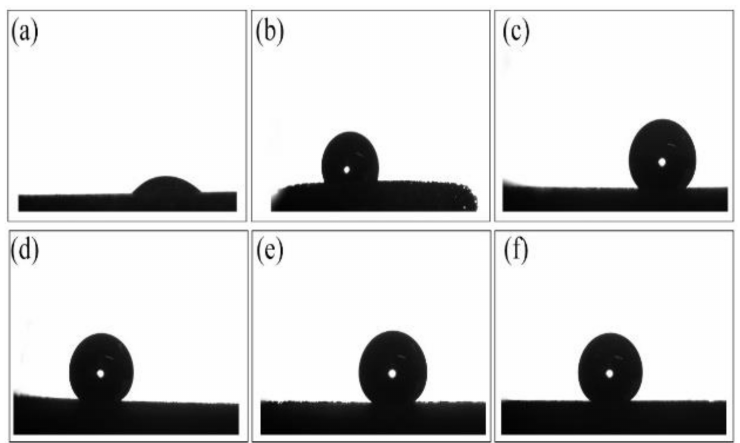
Figure 1. Upper : SEM characterization of the foam coppers (scale bar = 500 µ m). Numbers ( a – f ) stand for the blank copper foam, etched copper foam, copper foams modified using 15 mL EE ( n -ethanethiol), DE ( n -dodecanethiol), HDE ( n -hexadecanethiol), and ODE ( n -octadecanethiol) with an identical concentration of 1 mM, respectively; the insets ( a – e ) show the nanoscale patterns. The insets with a scale bar of 1 µ m show the enlarged view of the surface. Below : The WCAs of the Cu foams determined.